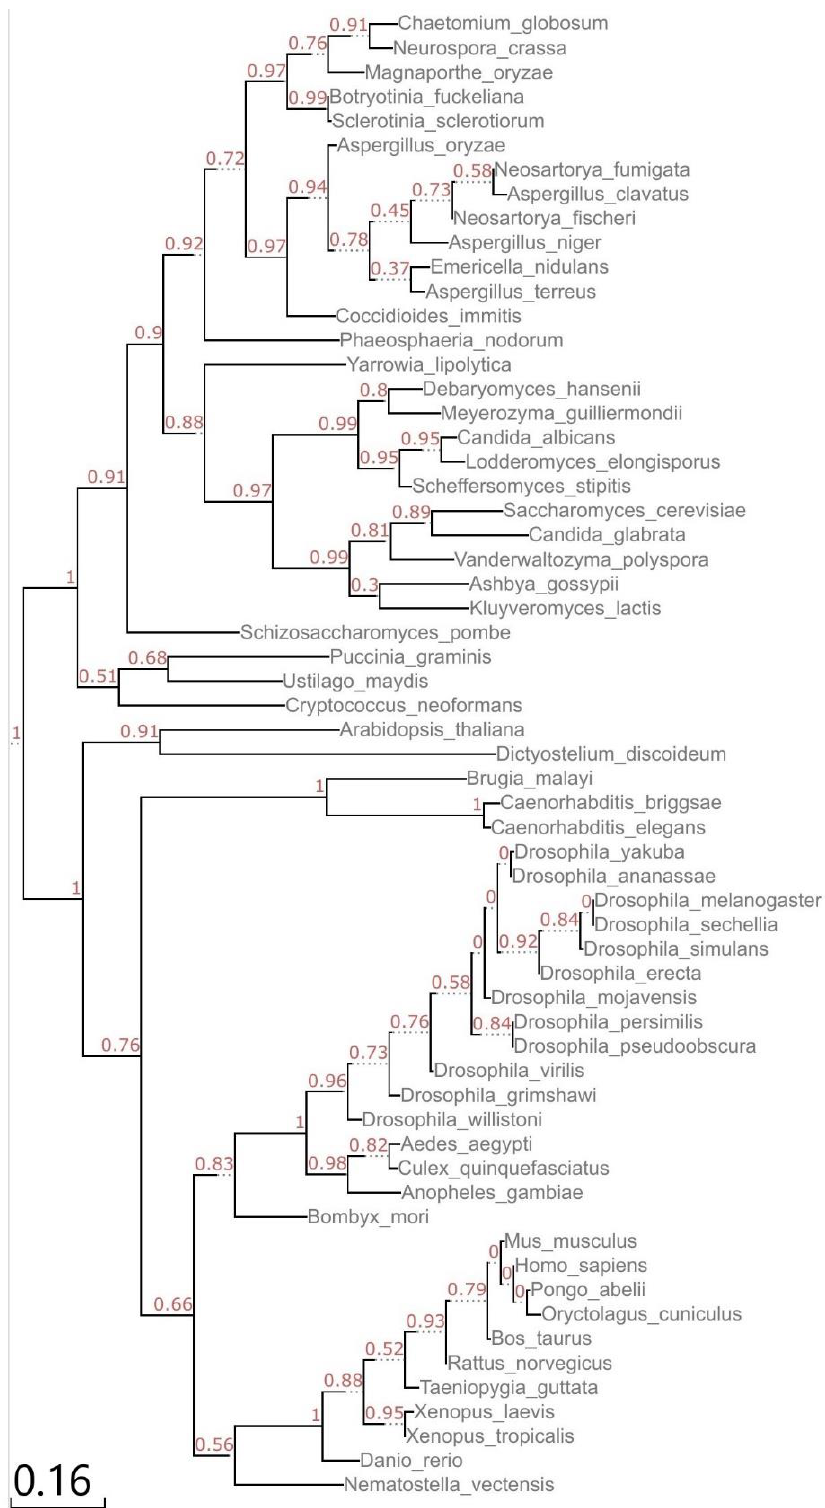
Figure 1. Phylogenetic Tree of EIF3i sequences. Tree constructed from sequence alignment using full-length EIF3i (TRIP-1) protein sequences from 61 eukaryotes.